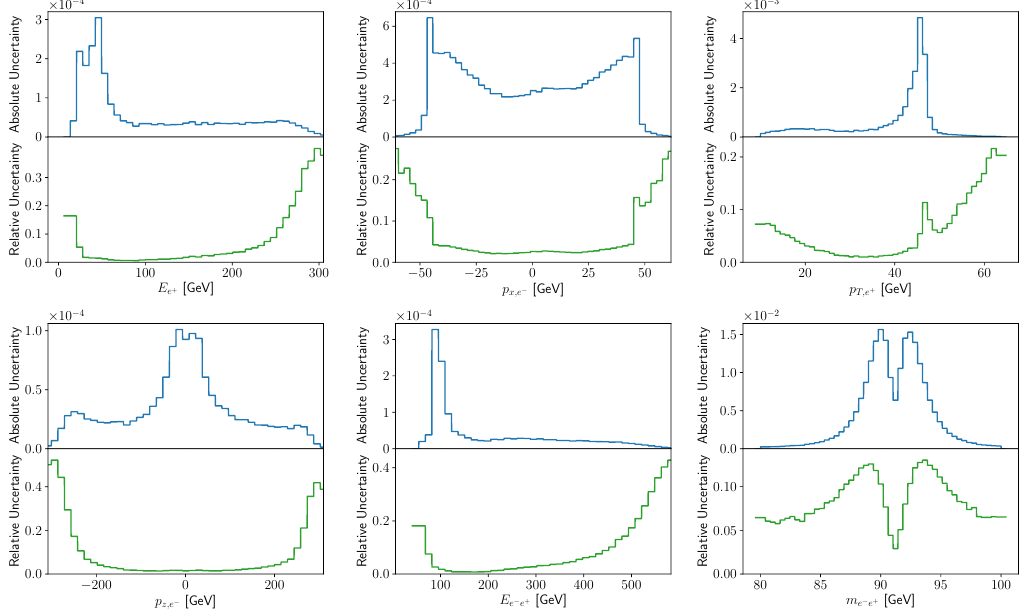
Figure 10: Absolute and relative uncertainties as a function of some of the kinematic Drell-Yan observables shown in Fig.